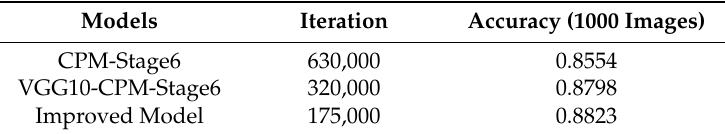
Table 5. The accuracy of the three